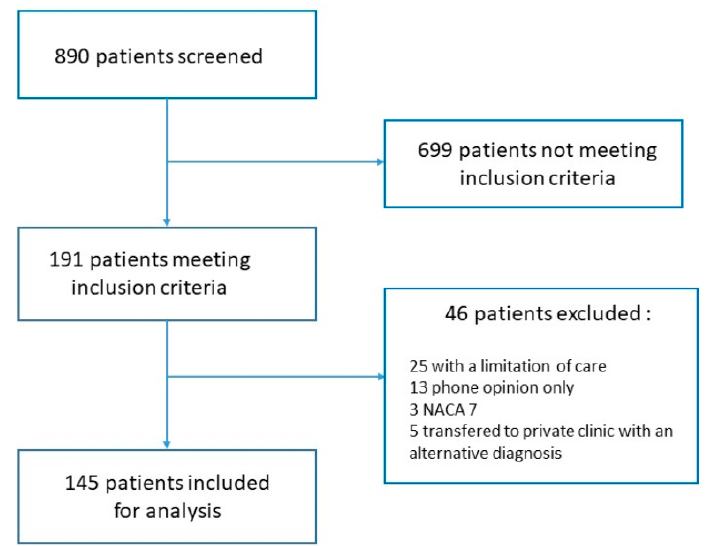
Figure 1. Flowchart of inclusion.